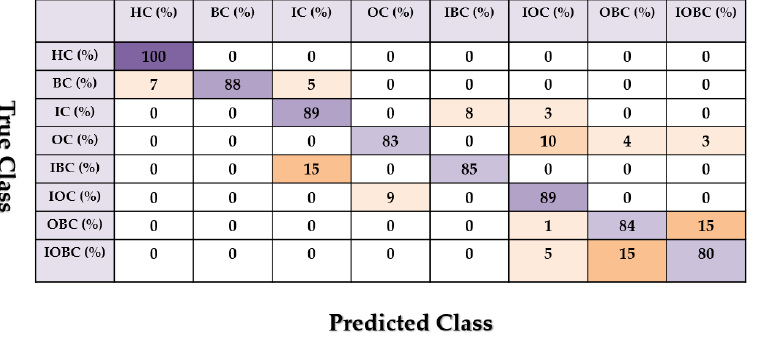
Figure 13. The average of crack type diagnosis using the combination of the ALSGL-SB and SVM approaches.